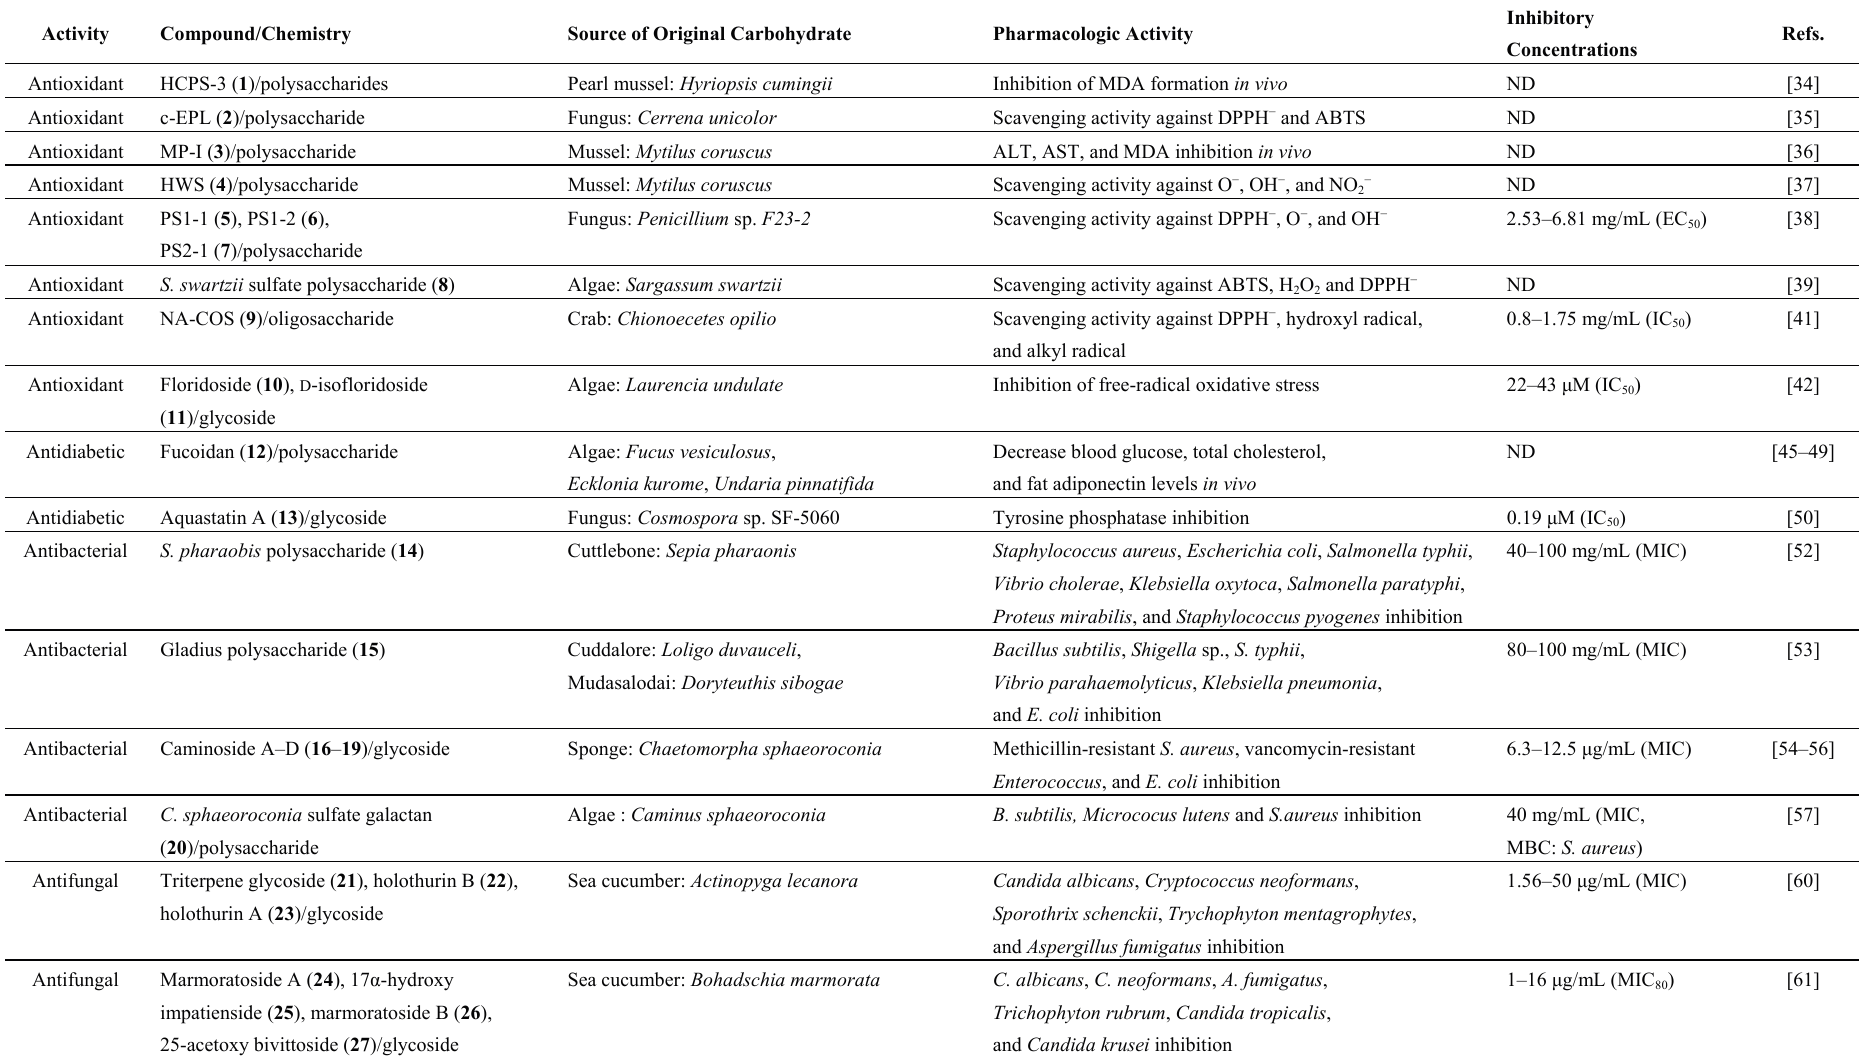
Table 1. List of bioactive carbohydrates and glycosides from diverse marine